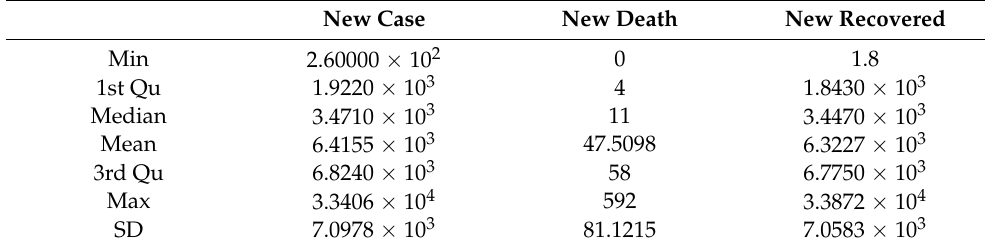
Table 1. Descriptive statistics of COVID-19 daily new cases, death, and recovered cases of